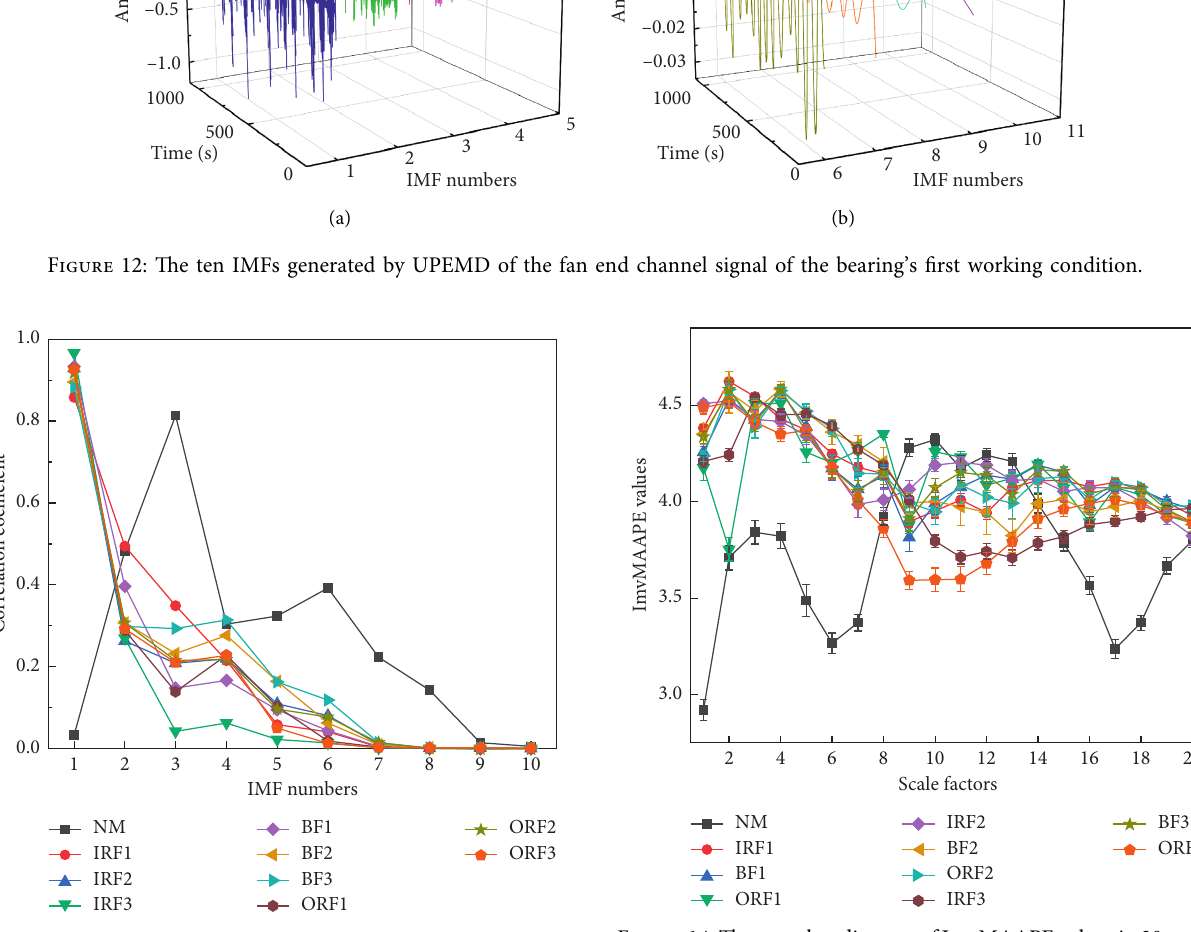
Figure 13: Correlation coefficients between the 10 IMFs and the bearing’s original signal under various working conditions.